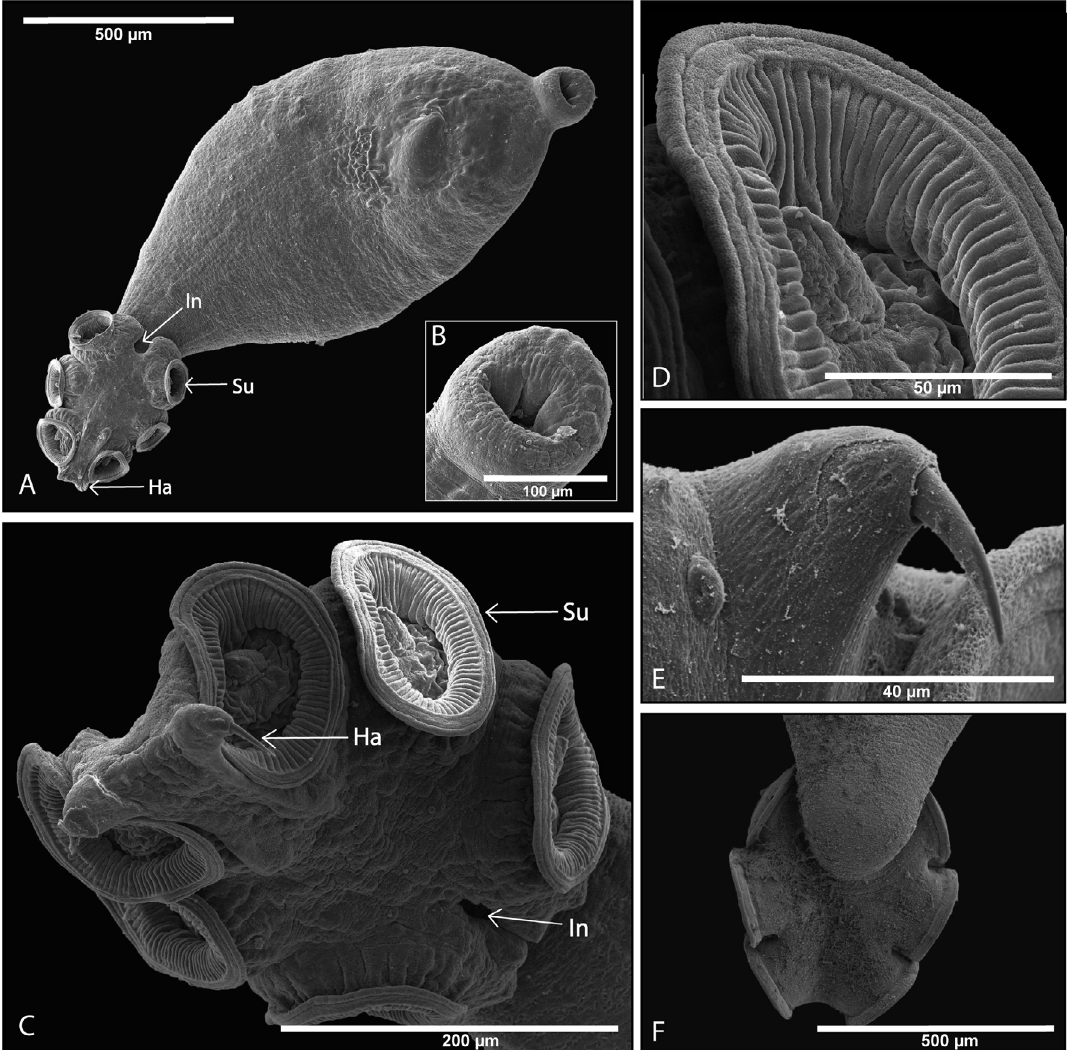
Figure 4. Scanning electron micrographs of mature Protopolystoma xenopodis specimens. (A) Ventral view of the parasite showing the mouth opening in the anterior of the parasite and the haptor armed with suckers ( Su), hamuli ( Ha) and a wedge-shaped infolding ( In) between the third sucker pair at the anterior margin of the haptor. (B) Ventral mouth opening. (C) Haptor with six ventral suckers ( Su), hamuli ( Ha) and a wedge-shaped infolding ( In) between the third sucker pair. (D) Single sucker showing the musculature of the sucker. (E) Hamulus point. (F) Dorsal view of the